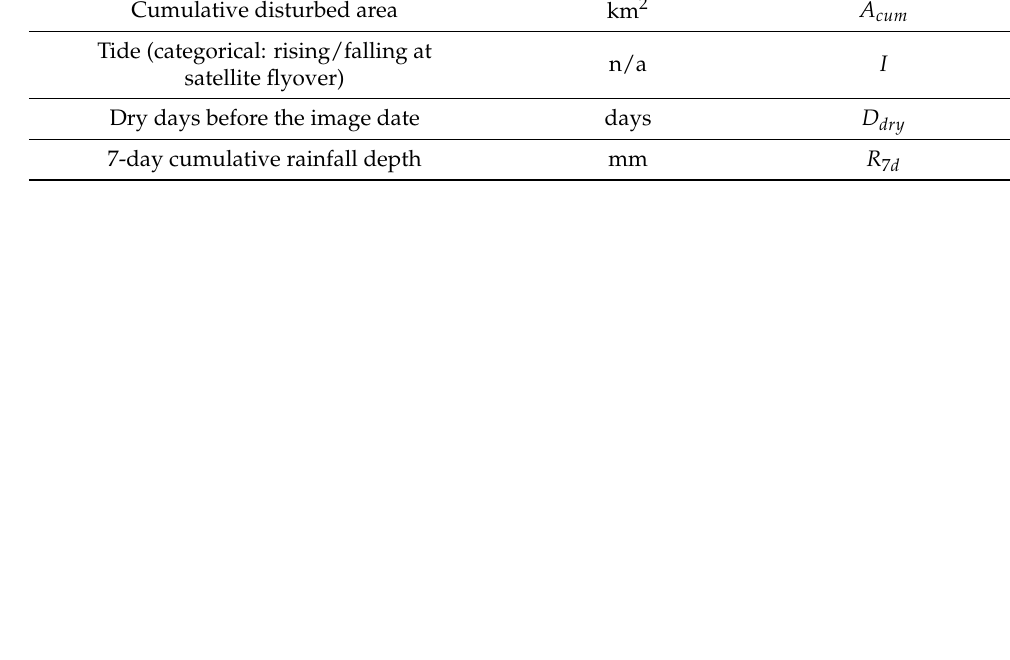
Table 7. List of main-effect predictor variables initially used in the variable selection process.